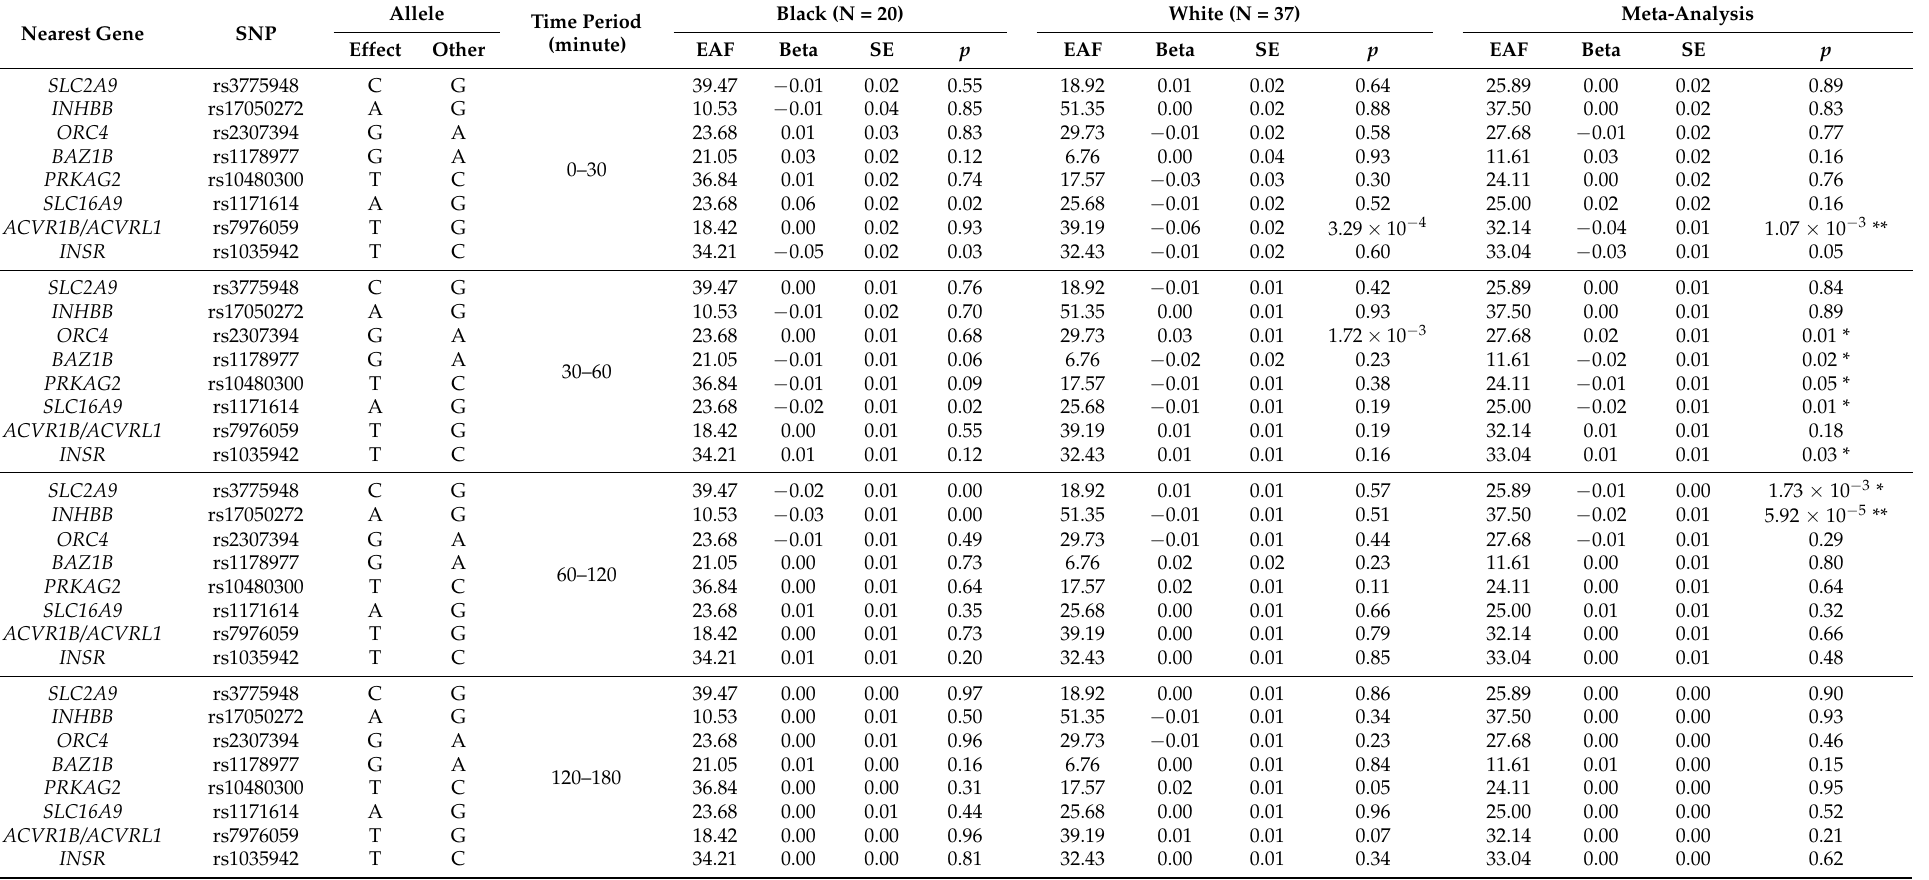
Table 4. Associations between SNPs and percent changes in serum urate for SNPs that reached statistical